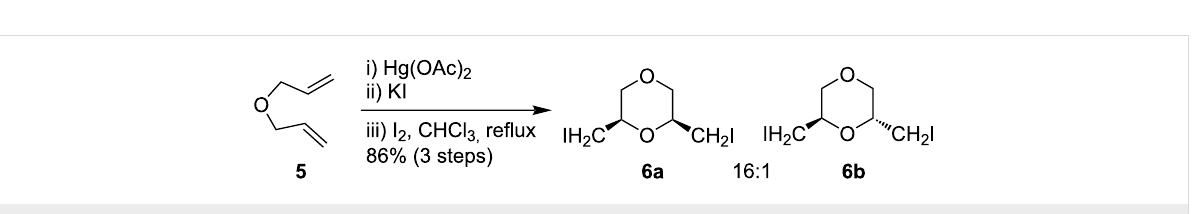
Scheme 3: Stepwise synthesis of 2,6-distubstituted dioxane derivatives.